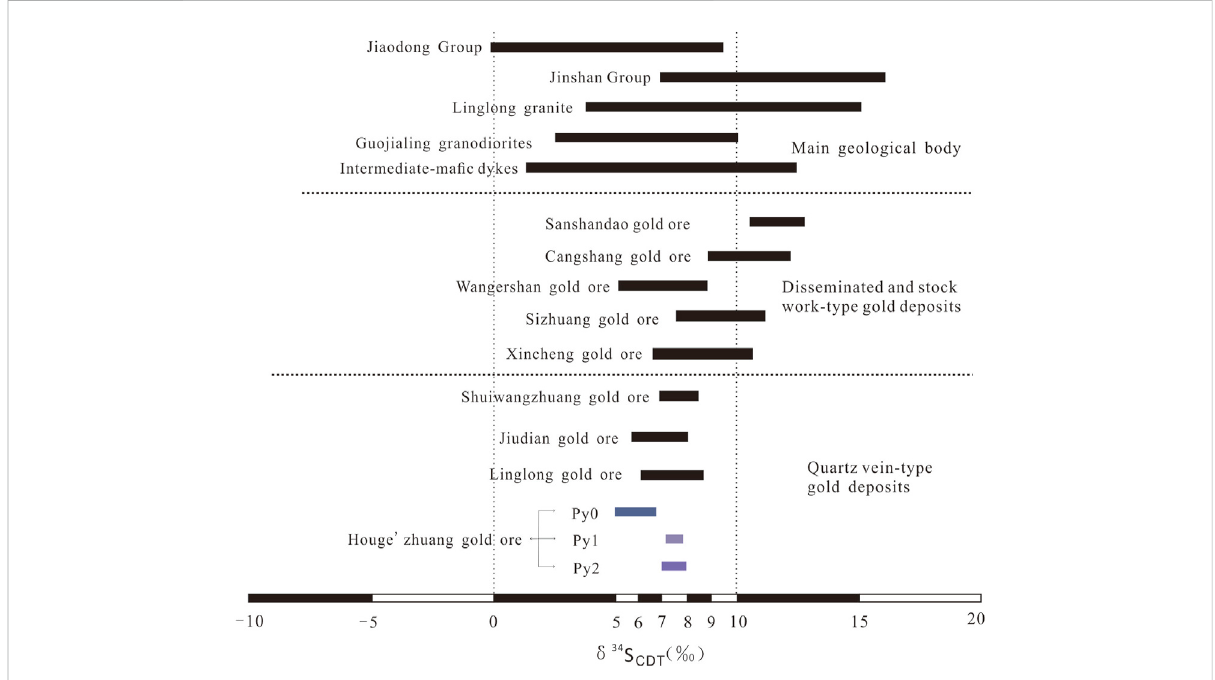
FIGURE 12 Sulfur isotope composition of Jiaodong group metamorphic rocks, granites, dykes, and ores of gold deposits in the northwestern Jiaodong area.